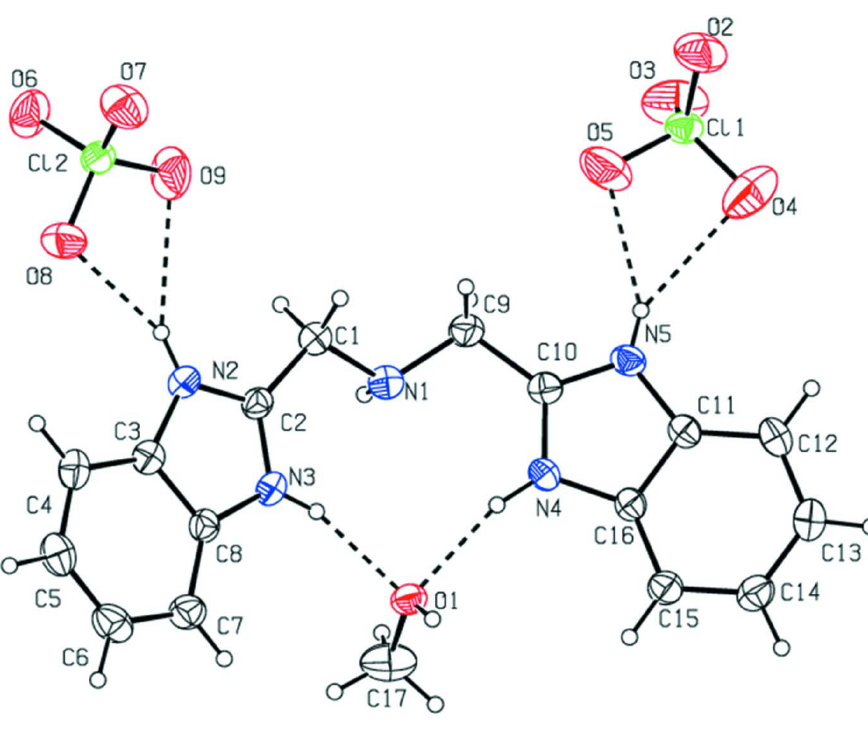
Figure 1 Molecular structure of the title compound, showing the atom-numbering scheme. Displacement ellipsoids are drawn at the 30% probability level and H atoms as spheres of arbitrary radius. Hydrogen bonds are shown as dashed